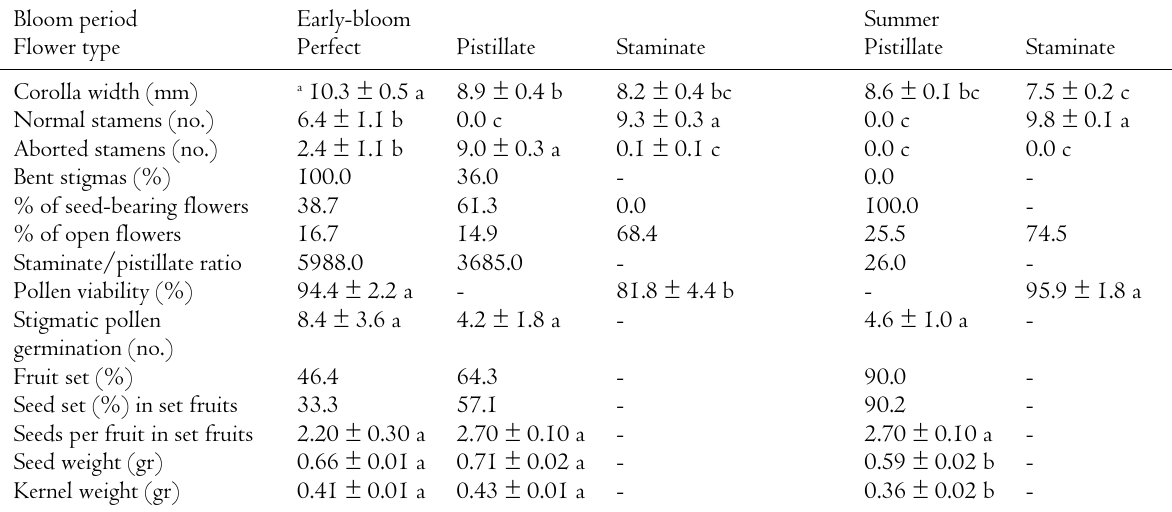
96% staminate and 4% pistillate flower buds.